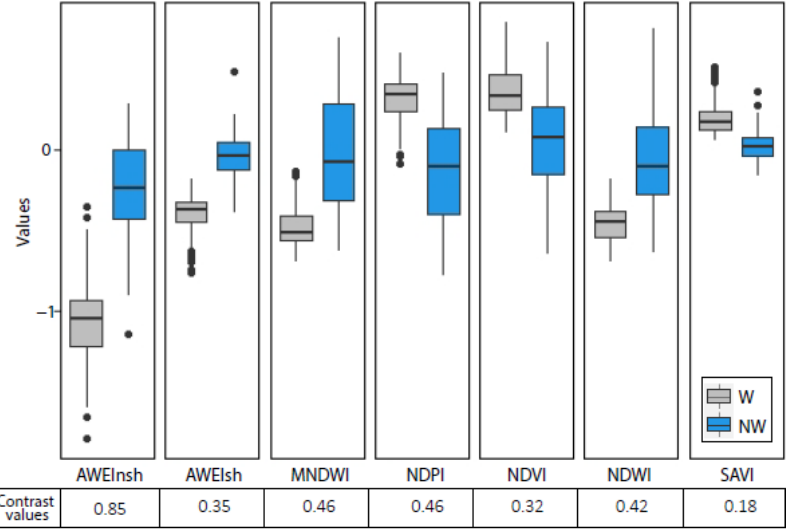
Figure 6. Box plots classified into water (W) and non-water (NW) categories and contrast values obtained for each index.